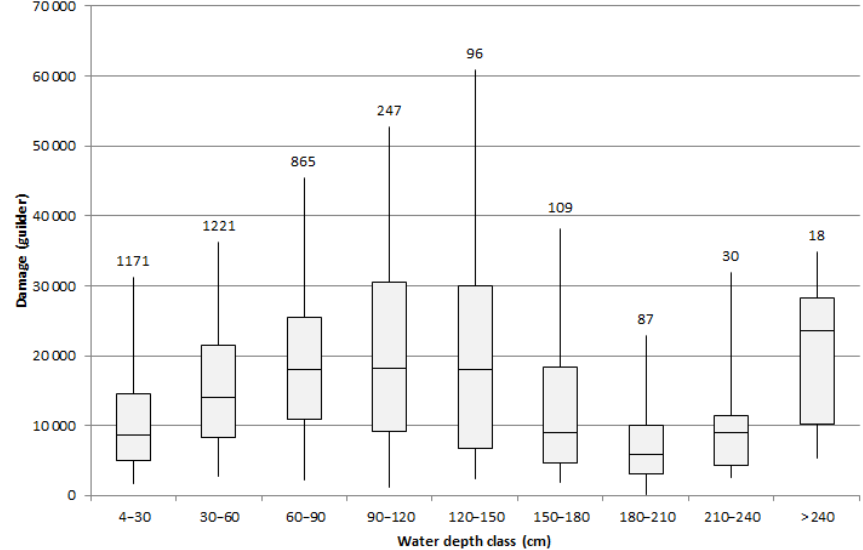
Figure 6. Box plots of the Meuse flood of 1993 per water depth class. The box shows the 25–75% interval and the lines show the 5–95% interval. The line in the middle of the box shows the median value. The labels on top of the plots show the number of observations per water depth